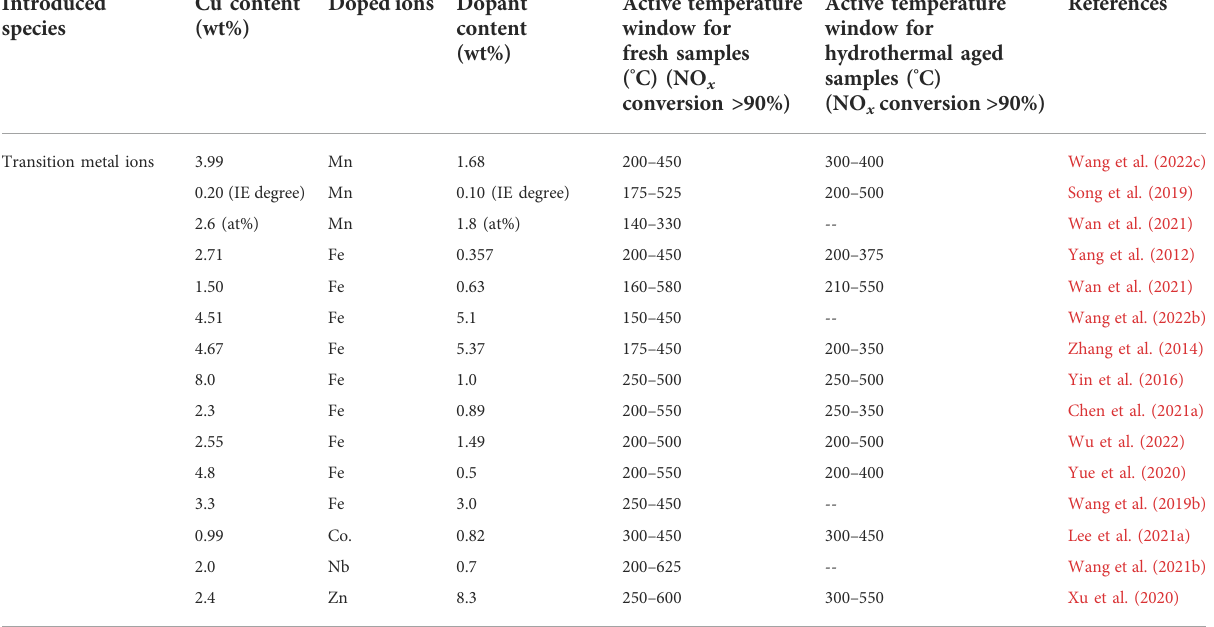
TABLE 2 Summary of the Cu-SSZ-13 catalysts doped with transition metal ions. Introduced